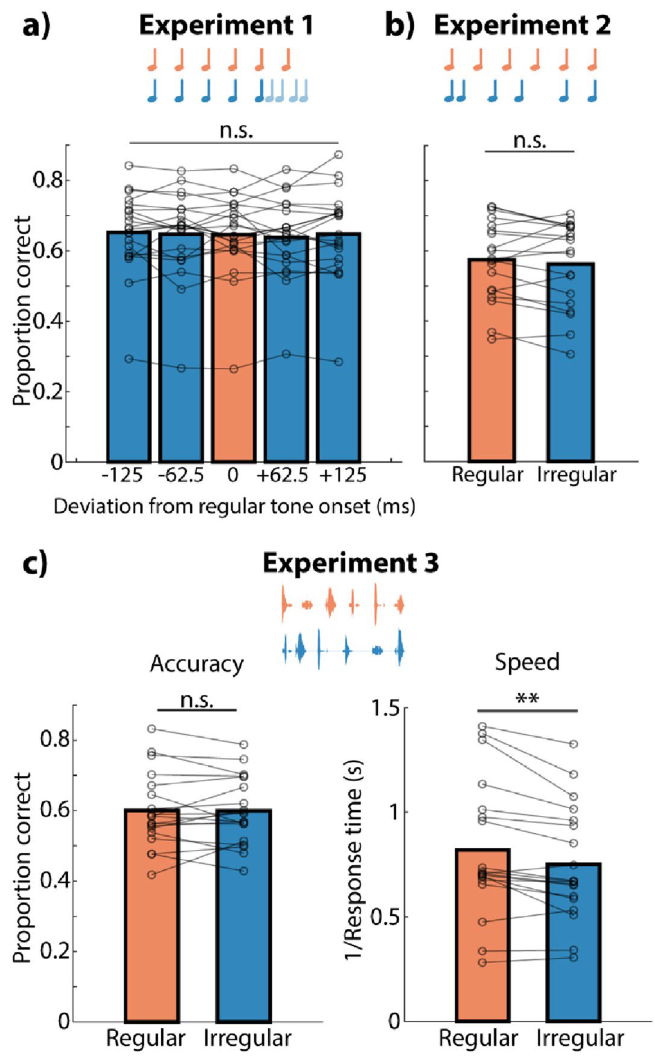
Figure 2. Serial recall performance in Experiment 1 ( a ), Experiment 2 ( b ), and Experiment 3 ( c ). ( a ) Proportion correct for different deviations of the sequence-final distractor tone from temporal regularity in Experiment 1. ( b ) Proportion correct in regular and irregular conditions in Experiment 2. ( c ) Left, Proportion correct in Experiment 3 for regular and irregular distractors. ( c ) Right, Response speed (1/RT). Bars show averages across all participants. Lines show data from individual participants. n.s. not significant. **p <